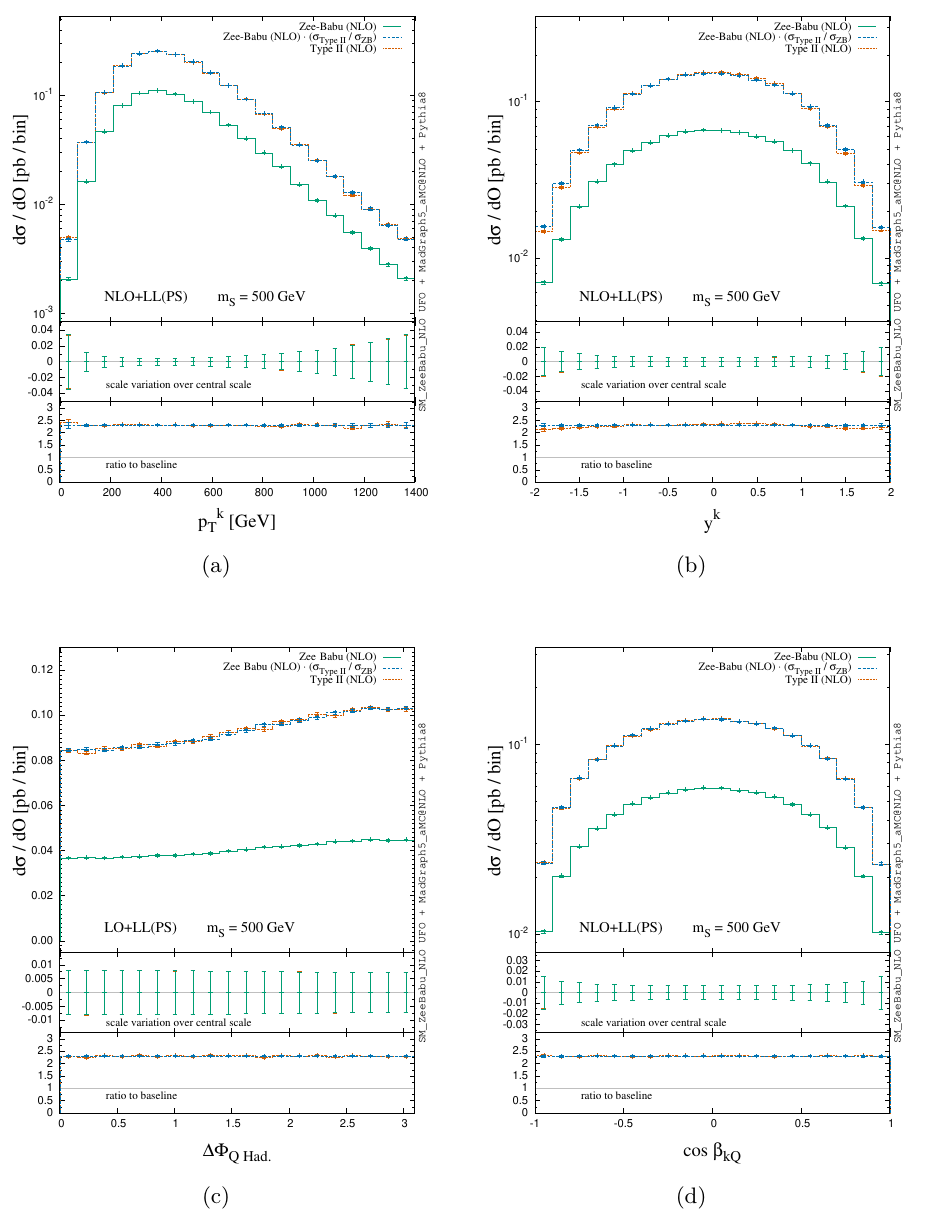
√ s = 13 TeV LHC, pp → SS † + X , , (b) y S , (c) T